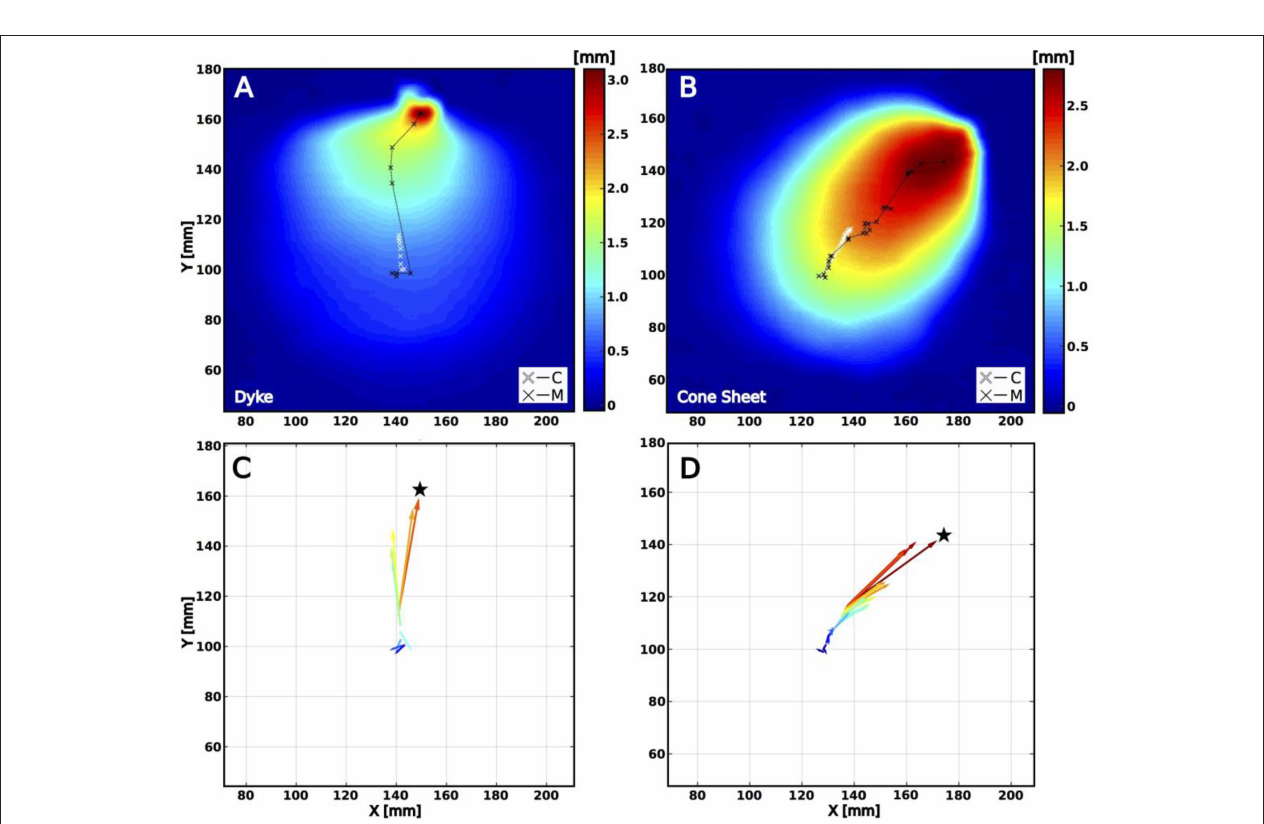
−→ V MC computed from the